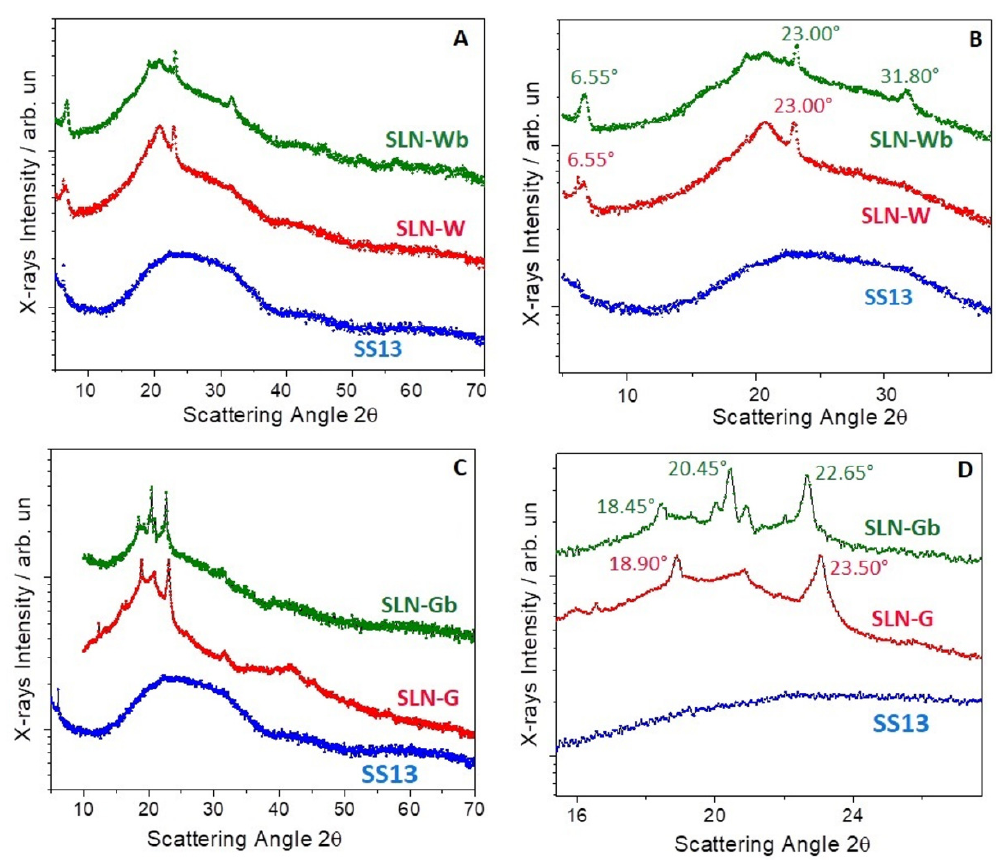
Figure 8. XRD pattern of SLNs prepared with Witepsol E85 (W) ( A , B ) and with the mixture of W/G ( C , D ). Magnification of XRD pattern of SLNs with W ( B ) and with W/G ( D ).